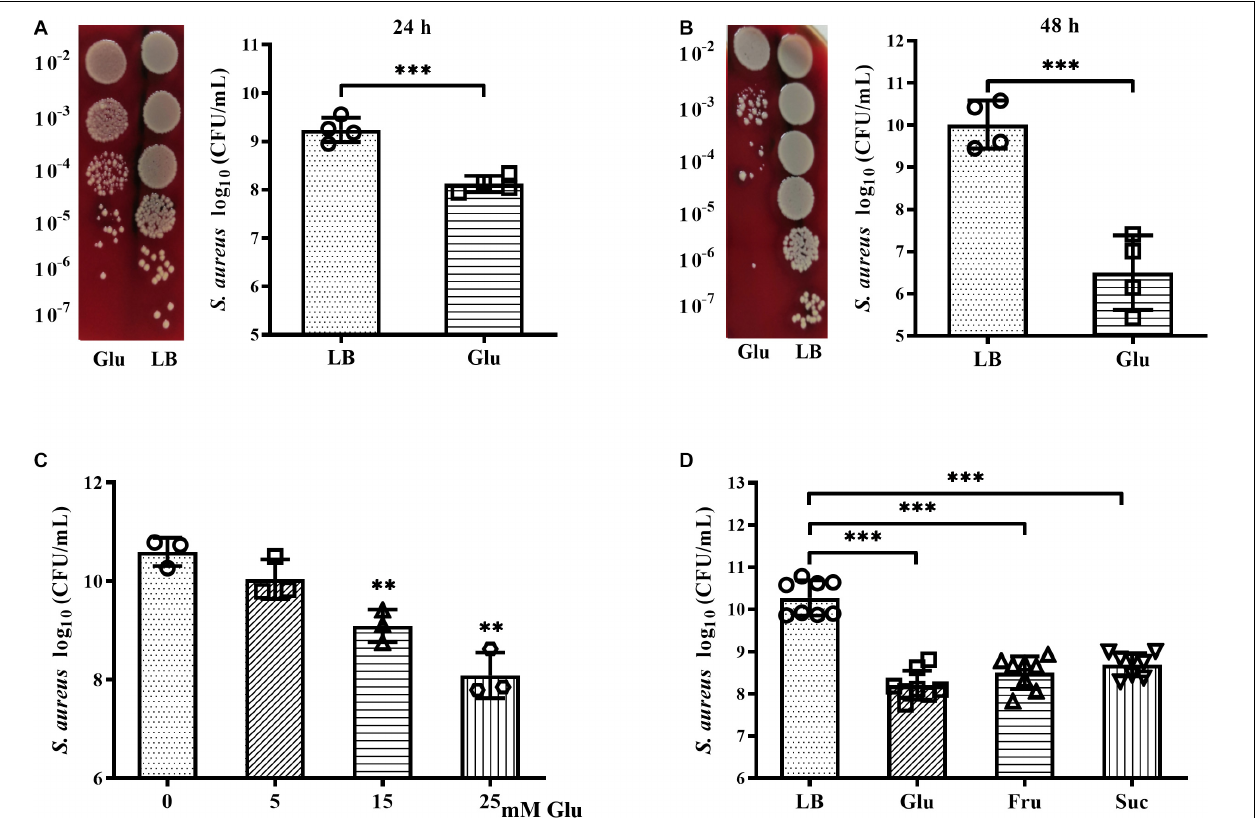
FIGURE 2 | Glucose reduced growth and survival of S. aureus Newman. (A) CFUs of S. aureus Newman cultured in LB medium with or without 25 mM glucose for 24 h, with serial dilution and plating on BA. (B) CFUs of S. aureus Newman cultured in LB medium with or without 25 mM glucose for 48 h. (C) CFUs of S. aureus Newman cultured in LB medium supplemented with 0, 5, 15, or 25 mM glucose for 24 h. (D) CFUs of eight clinical S. aureus isolates from diabetic patients with foot ulcers cultured in LB medium with or without 25 mM glucose, 25 mM fructose, or 12.5 mM sucrose for 24 h. ∗∗ p < 0.01; ∗∗∗ p <